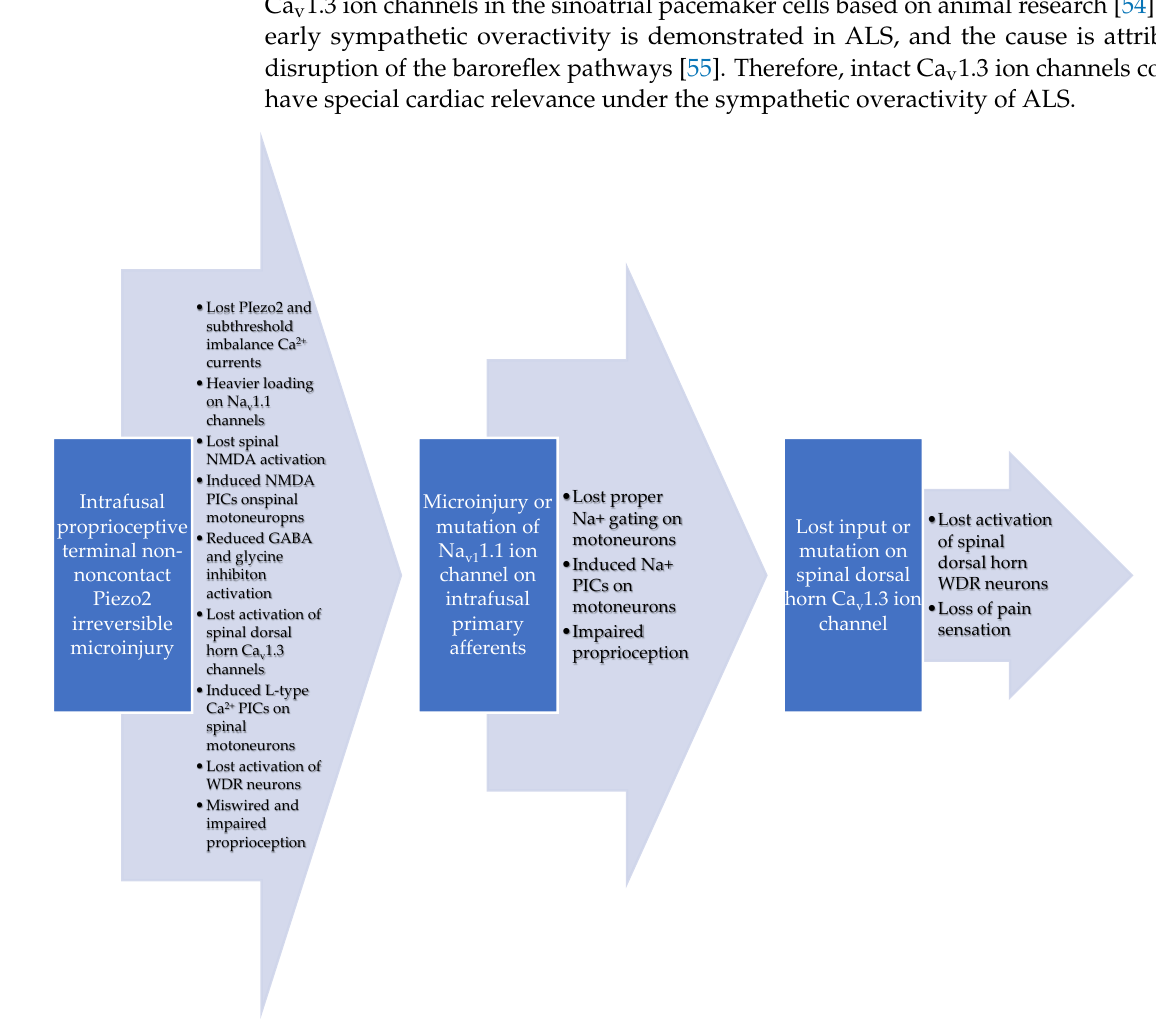
Figure 2. Proposed dysregulated pain pathways in ALS based on intrafusal noncontact proprioceptive terminal Piezo2 irreversible microinjury-induced miswired proprioception [19].